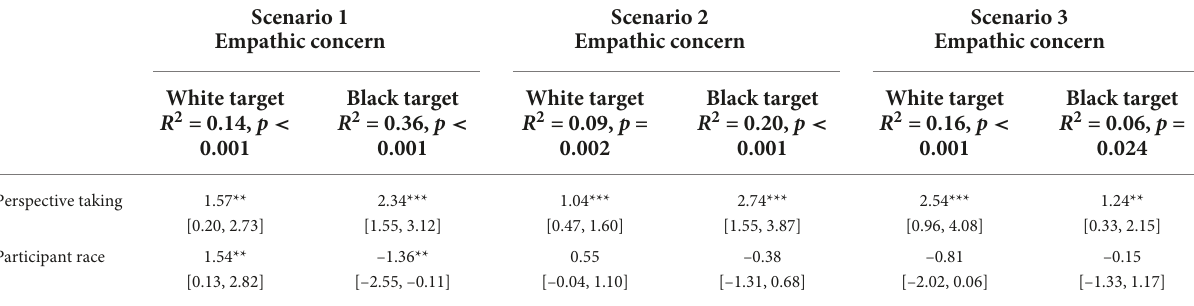
TABLE 2 Simultaneous regressions predicting empathic concern as a function of perspective taking and participant race: Study